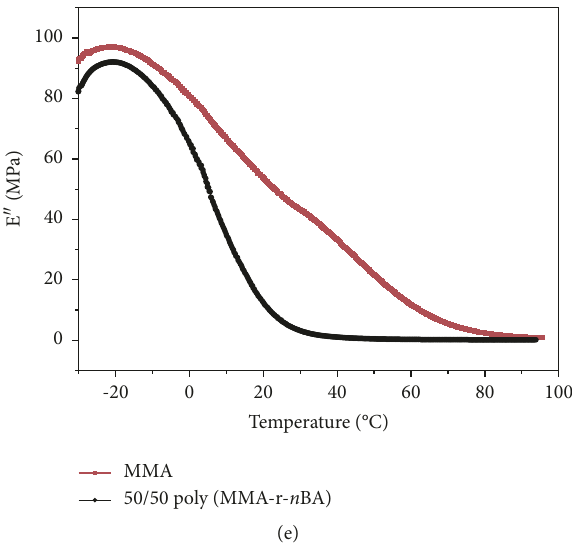
Figure 6: Thermal property of polymers and their mechanical analysis. (a) TG stage curves of the MMA and poly(MMA-r-nBA) polymers. (b) DTG curves of the MMA and poly(MMA-r-nBA) polymers; The two grey boxes represent peaks at approximately 350 ° C and 370 ° C, respectively. (c-e) DMA curves of the MMA and 50/50 poly(MMA-r-nBA) samples. The test data includes storage modulus, loss factor (Tg), and loss modulus.